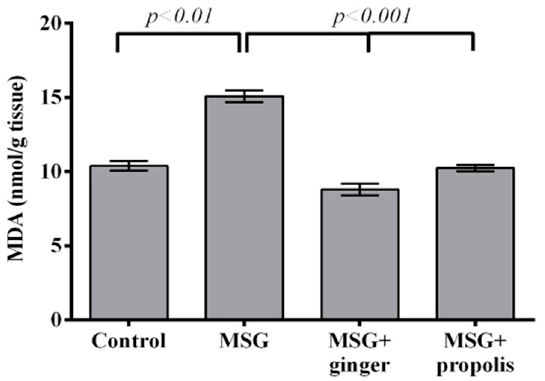
Figure 4. Effects of ginger and propolis aqueous extracts on the brain tissue MDA level of the experimental groups. Data are expressed as mean ± SEM ( n = 6). Comparisons were made between normal control and MSG control group, and between MSG control and MSG plus ginger or propolis supplement groups.